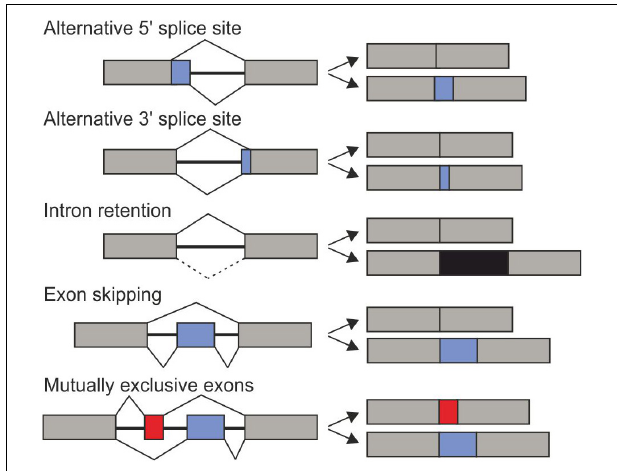
FIGURE 1 | Main types of alternative splicing events. Exons are shown as boxes and black line represent introns. Constitutively expressed exons are exhibited in gray and alternatively spliced intorns are black, red or